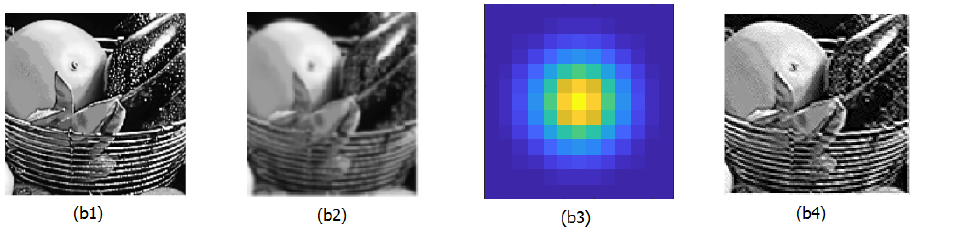
Figure 5. Original image ( b1 ); blurred image ( b2 ); Gaussian-(2,2) point-spread function ( b3 ); and ( b4 ) deblurred image obtained by the exponentiated-gradient learning algorithm.